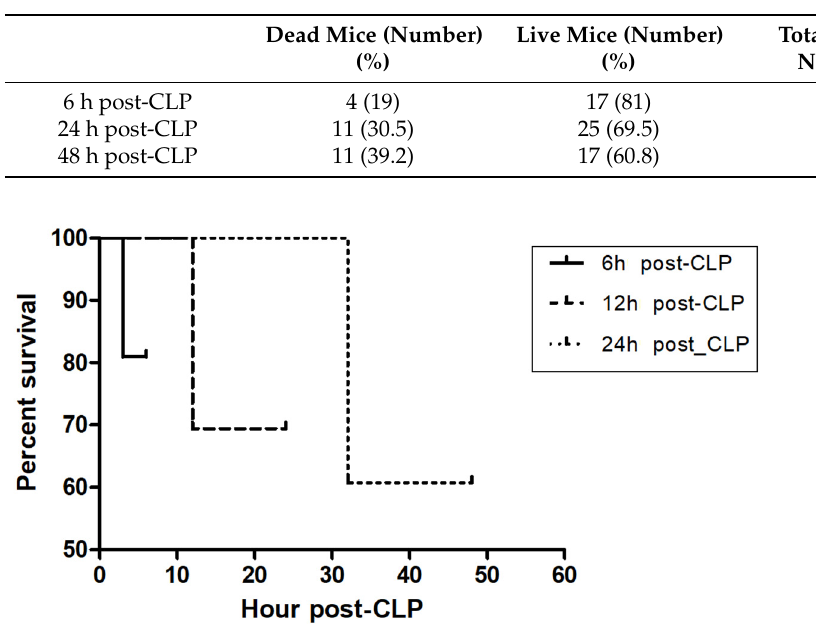
Table 1. Lethality of CLP-induced sepsis mice.